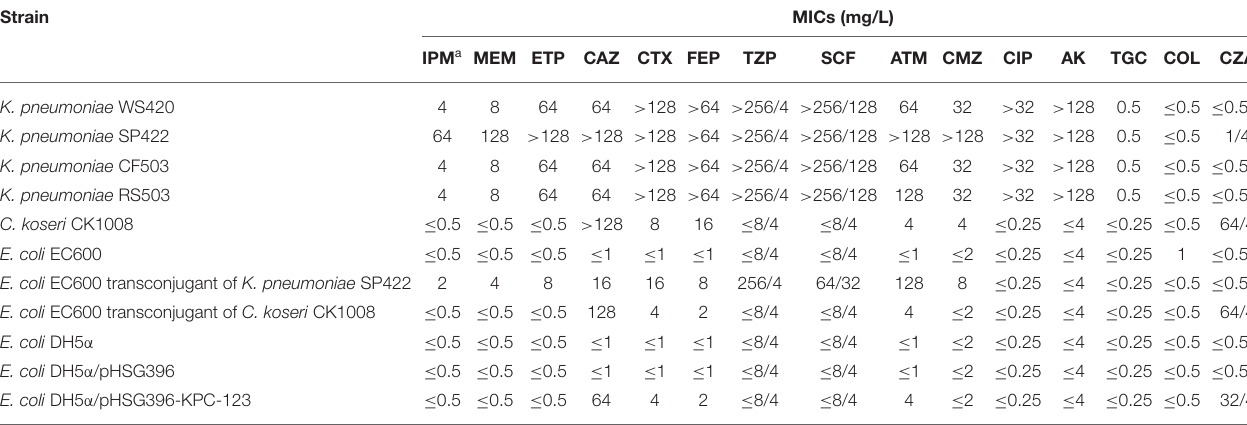
TABLE 2 | Antimicrobial susceptibility results of C. koseri CK1008 and four K. pneumoniae isolates and their E. coli transconjugants and transformants.